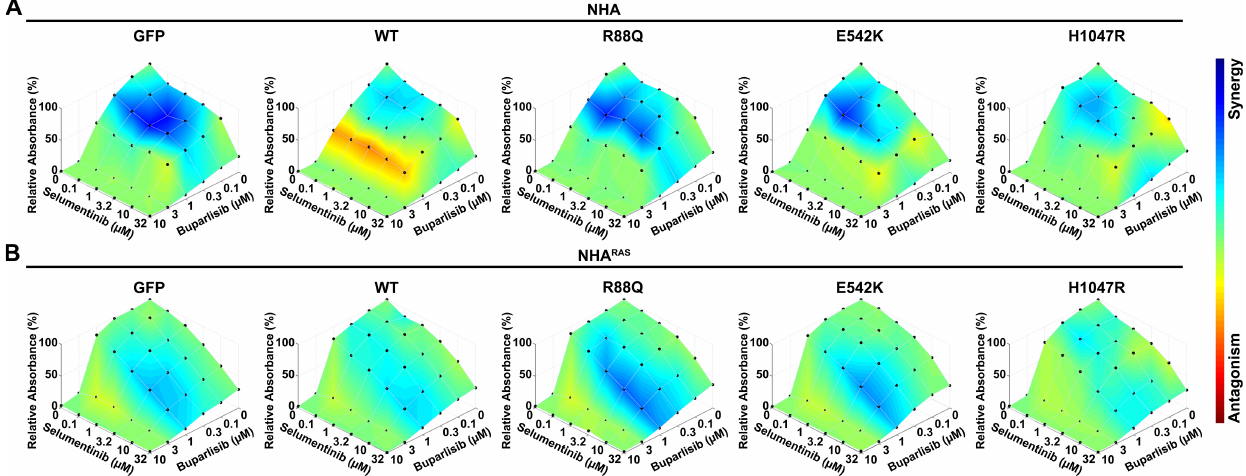
Fig 6. PI3Ki/MEKi synergism in vitro is influenced by PIK3CA mut and mutant RAS . Buparlisib and selumetinib inhibited growth and were synergistic in control and PIK3CA mut NHA ( A ) and NHA RAS ( B ). BLISS showed that synergy was most pronounced with high nanomolar buparlisib and low micromolar/high nanomolar selumetinib in NHA lines. In contrast, synergistic concentrations in NHA RAS lines were generally most pronounced at both low micromolar buparlisib and selumetinib.